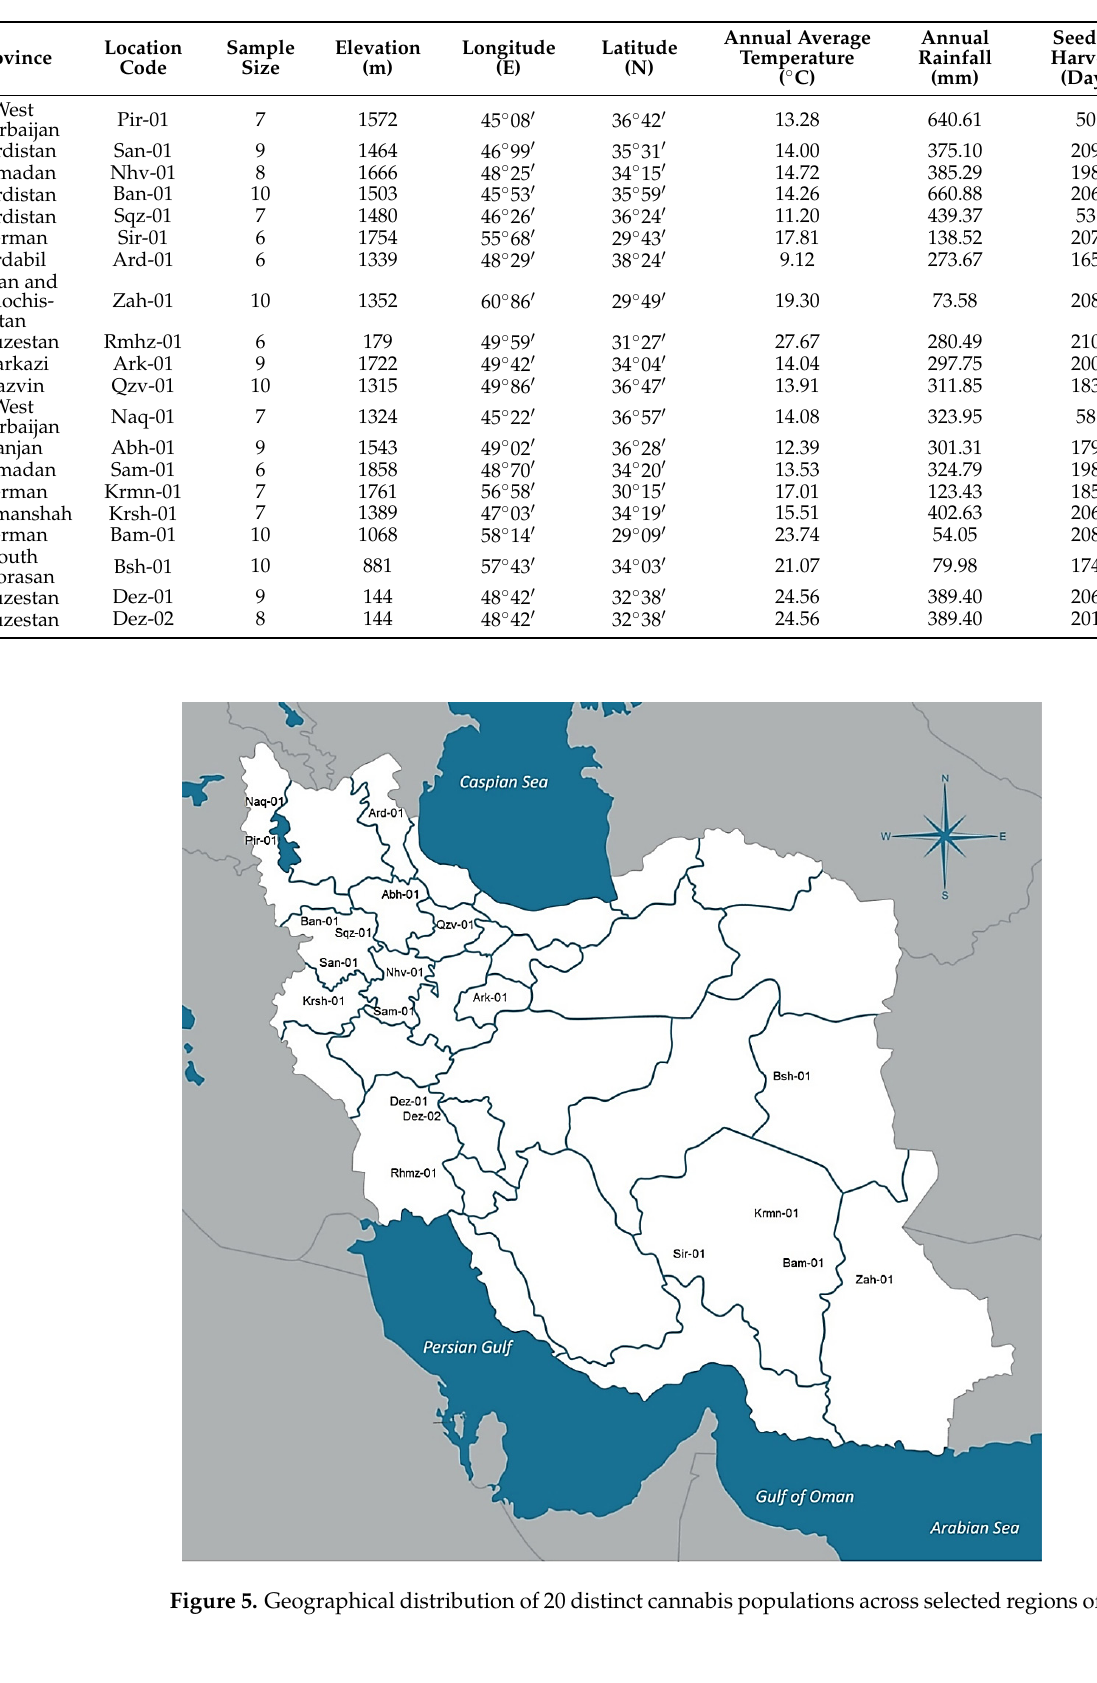
Table 2. Geographical data of native cannabis genotypes were collected from different selected regions of Iran.